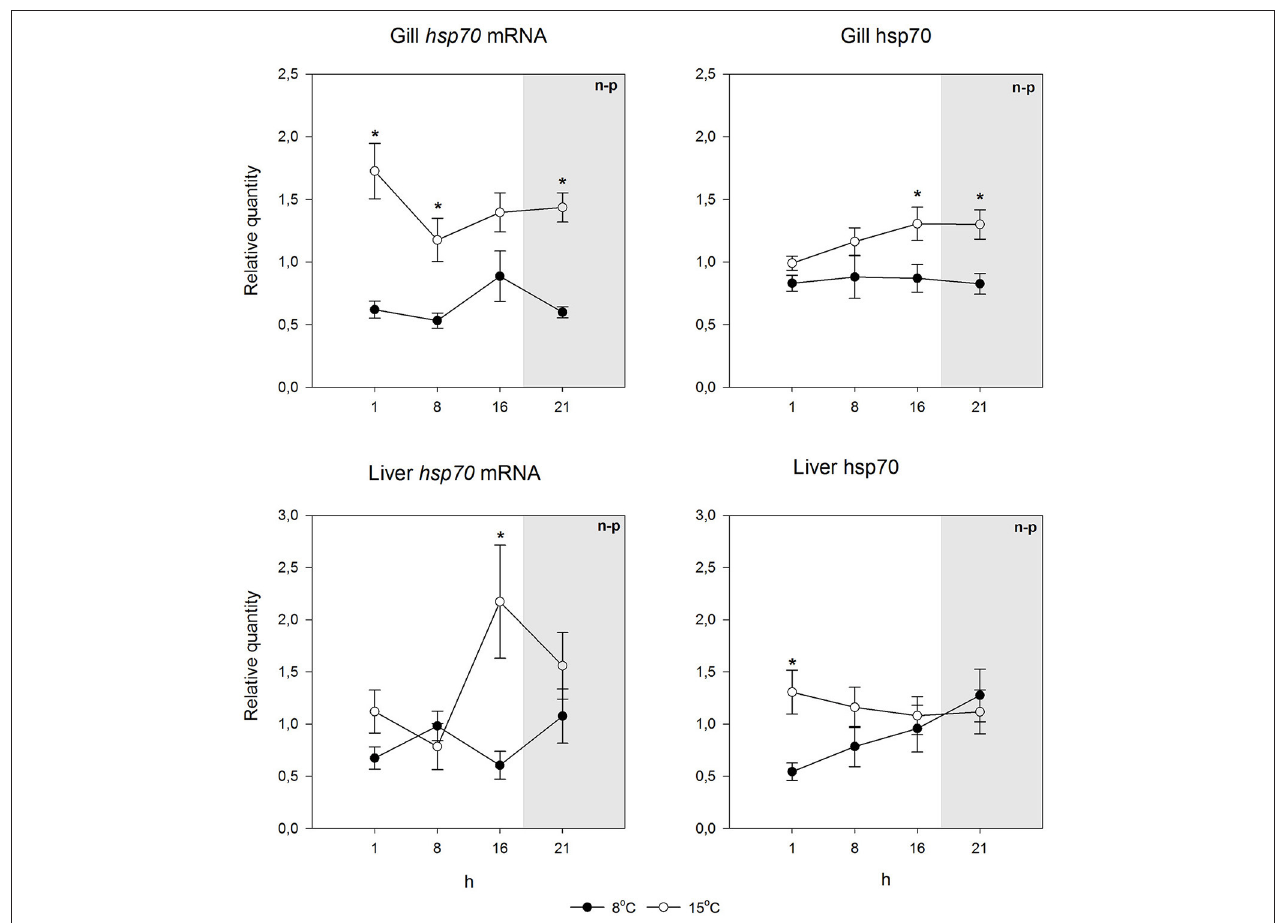
FIGURE 2 | Hsp70 mRNA and protein levels at different times of the 24-h light/dark cycle in undisturbed Arctic charr. Relative quantities (mean ± SEM; n = 7) are given. Whenever ANOVA or Kruskal-Wallis on ranks [parametric (p) or non-parametric (n-p), respectively] indicated statistically significant differences post-hoc testing (Holm-Sidak or Dunn’s method) was conducted. * indicates significant differences between acclimation temperatures at the same time point ( p < 0.05 was accepted as statistically significant effect). There were no significant differences between time points within an acclimation temperature. Dark period is indicated by gray